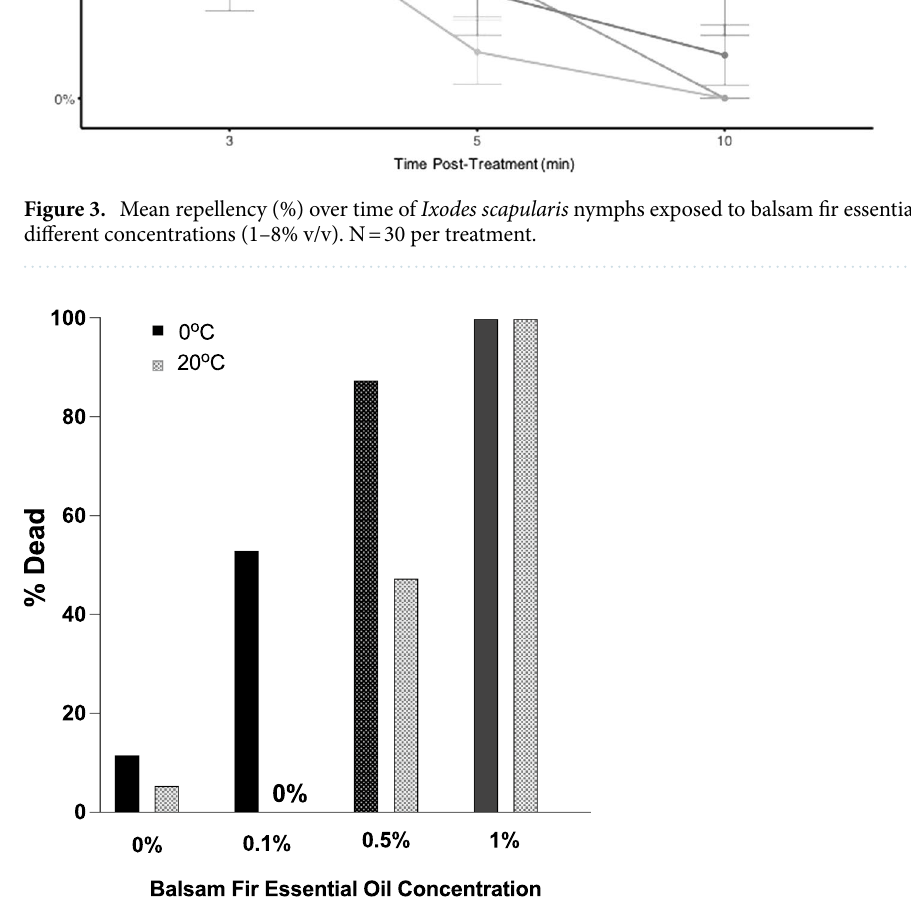
Figure 4. Balsam fir essential oil killed ticks at a lower concentration at 2 °C than at 20 °C. The black bars represent the mortality at 2 °C while the grey bars represent mortality at 20 °C. N = 32 for each bar except N = 36 at